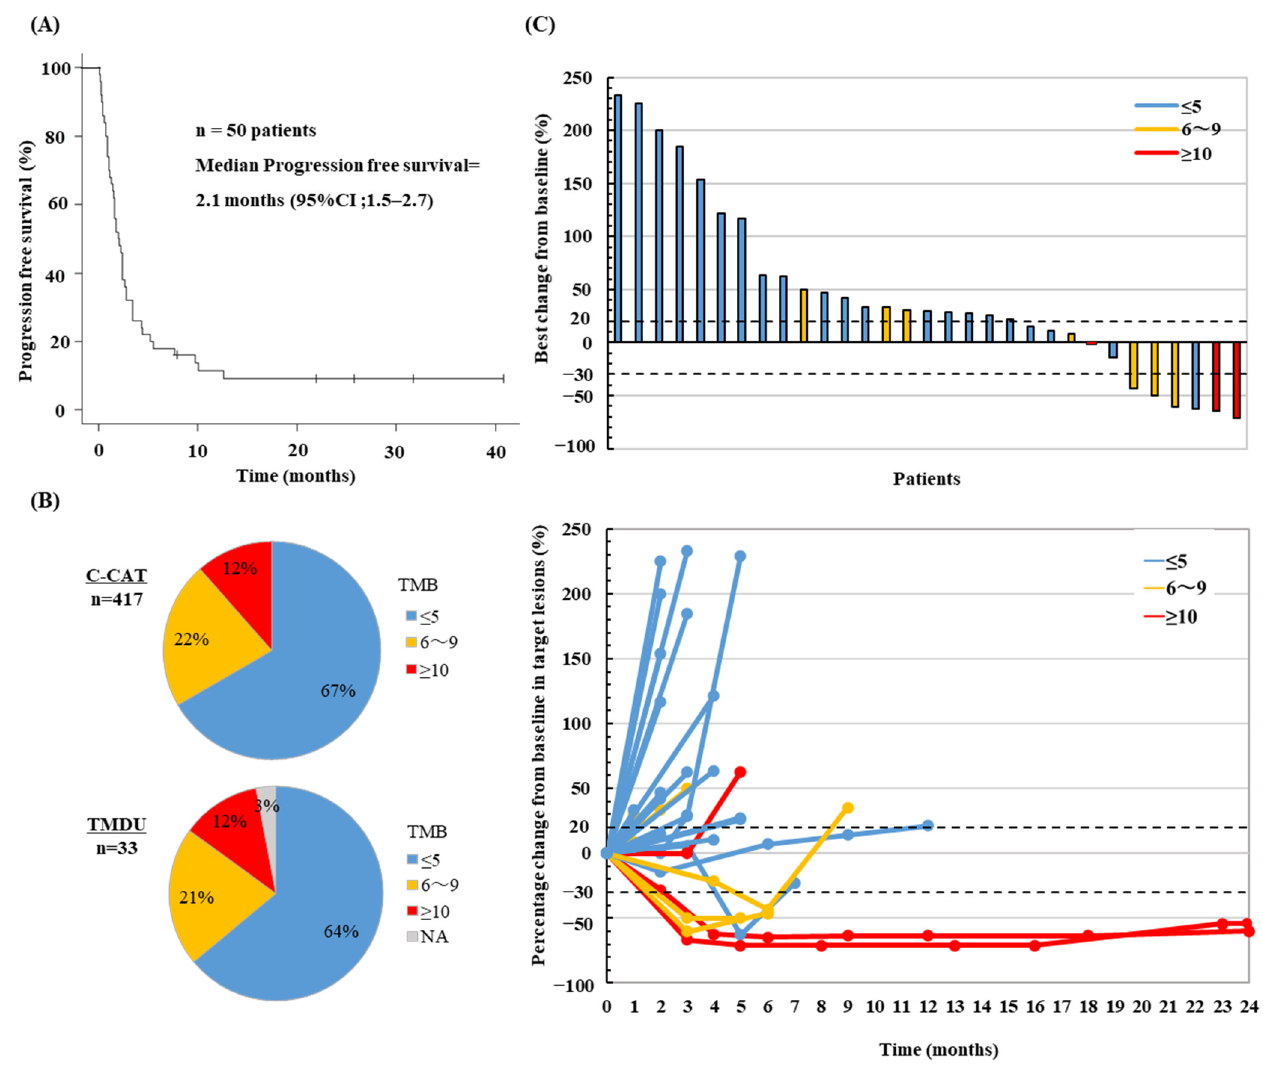
Figure 3. Outcomes of ICI therapy and association between TMB. ( A ) The Kaplan–Meier curves for progression-free survival among R/M HNSCC patients who have received ICI monotherapy to date in our department. ( B ) The percentage of TMB value in C-CAT and TMDU. ( C ) Response to ICI monotherapy in R/M HNSCC patients in the study. All 34 R/M HNSCC patients in this study had received ICI therapy. Of these, 1 patient who received ICI and chemotherapy, one patient who was not evaluable (NE) due to treatment interruption, and one patient with no detectable TMB value were excluded. For 31 patients, the waterfall plot (top) shows the best percent change from baseline in target lesions. Spider plot (bottom) showing objective response during ICI treatment. Color coding indicates TMB values; high (red, ≥ 10 Mut/Mb), medium (yellow, 6–9 Mut/Mb), and low (blue, ≤ 5 Mut/Mb). CI, confidence interval.